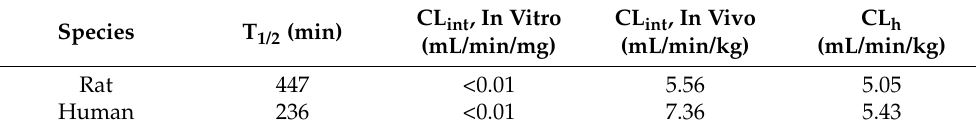
Table 5. Metabolic stability parameters of α‐ amanitin in rat and human liver microsomes. CL int , In Species T 1/2 (min)